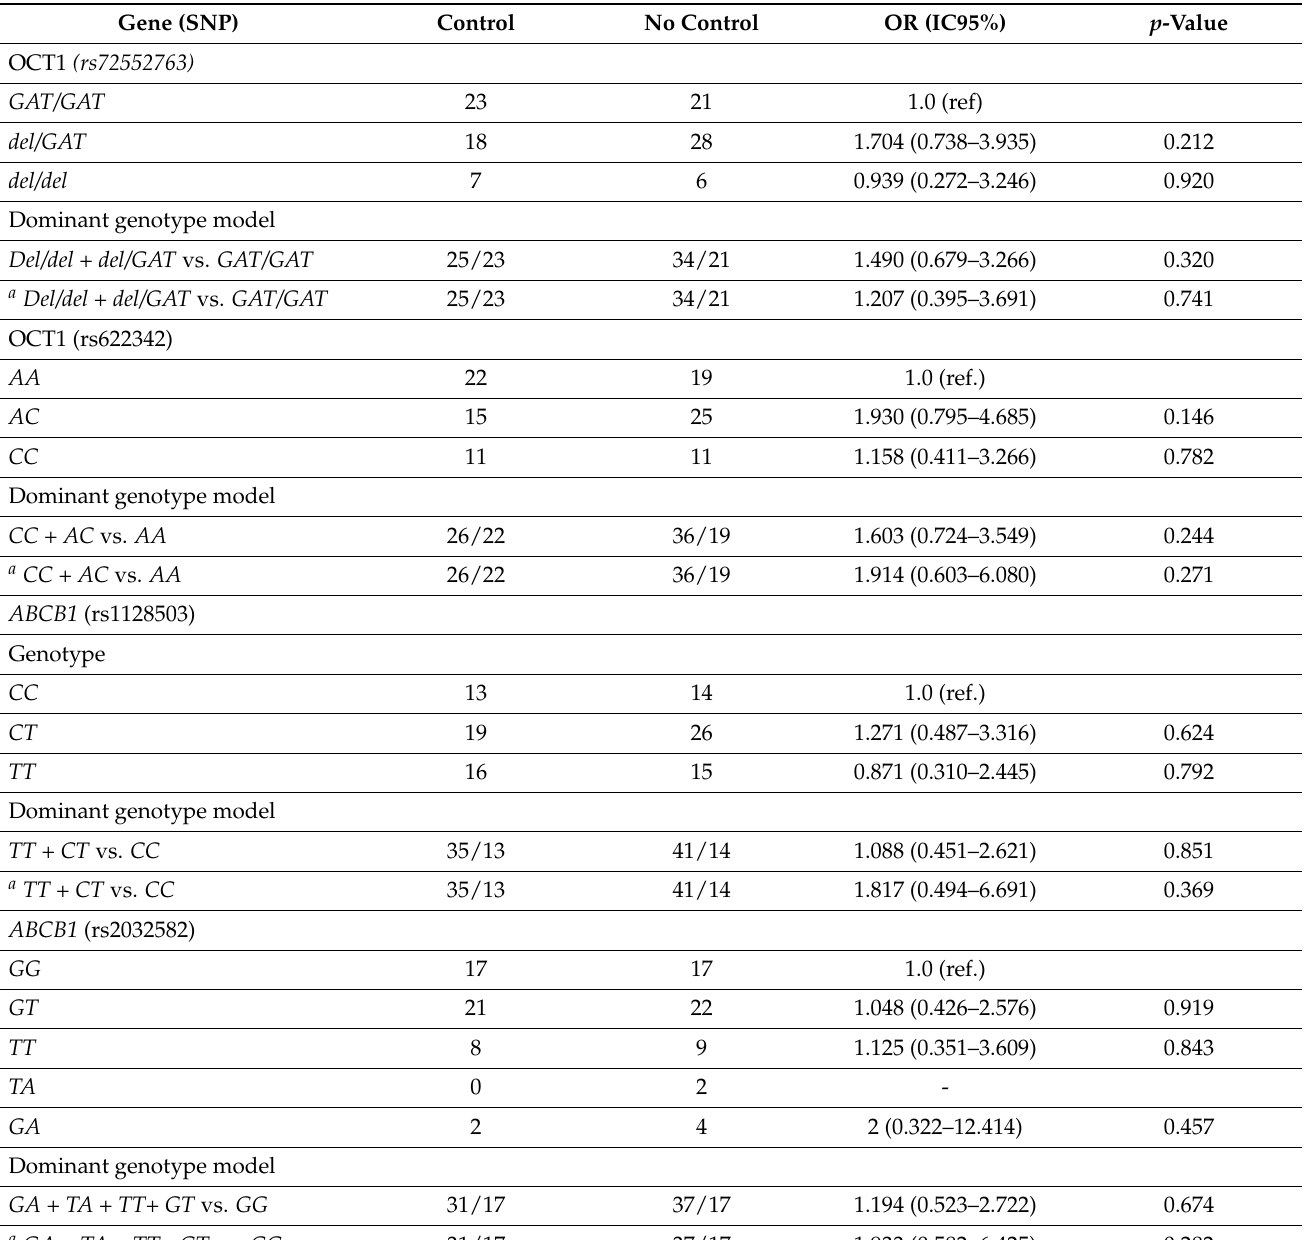
Table 6. Logistic regression on genotypic models in OCT1 and ABCB1 across uncontrolled